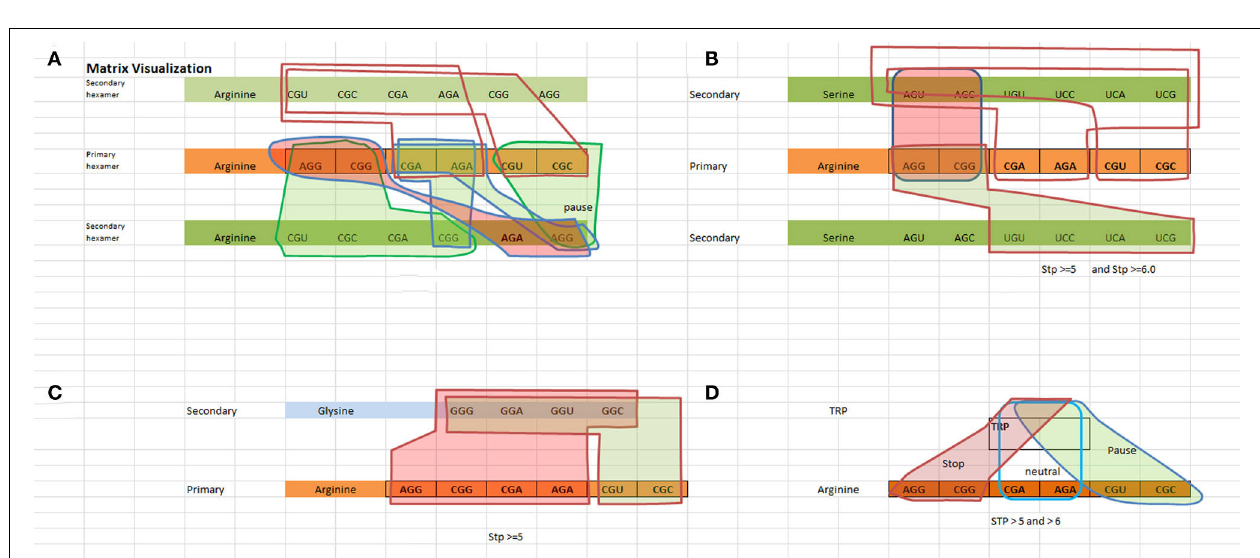
FIGURE 1 | Visualization of the TP hexamers starting with the primary codon followed by the secondary codon. Red highlighted regions indicate a “not allowable” state, green highlighted regions indicate a “pausing” state, and no highlighted regions indicate a neutral state (no pausing). (A) Visualizes the States for a Arginine–Arginine hexamer. (B) Visualizes the states for a Arginine–Serine hexamer. Looking at the red shaded area representing “not allowed” states, any one of the red highlighted arginine codons followed by